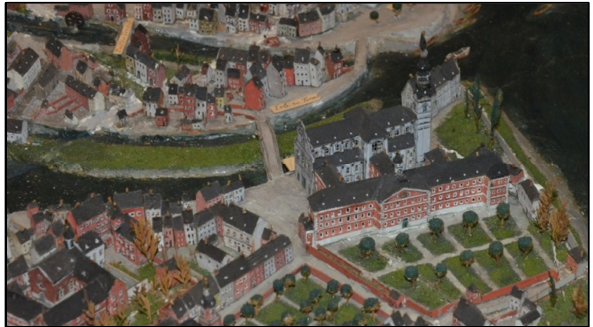
Figure 1. Photography of Gustave Ruhl’s scale model representing the City of Liege around